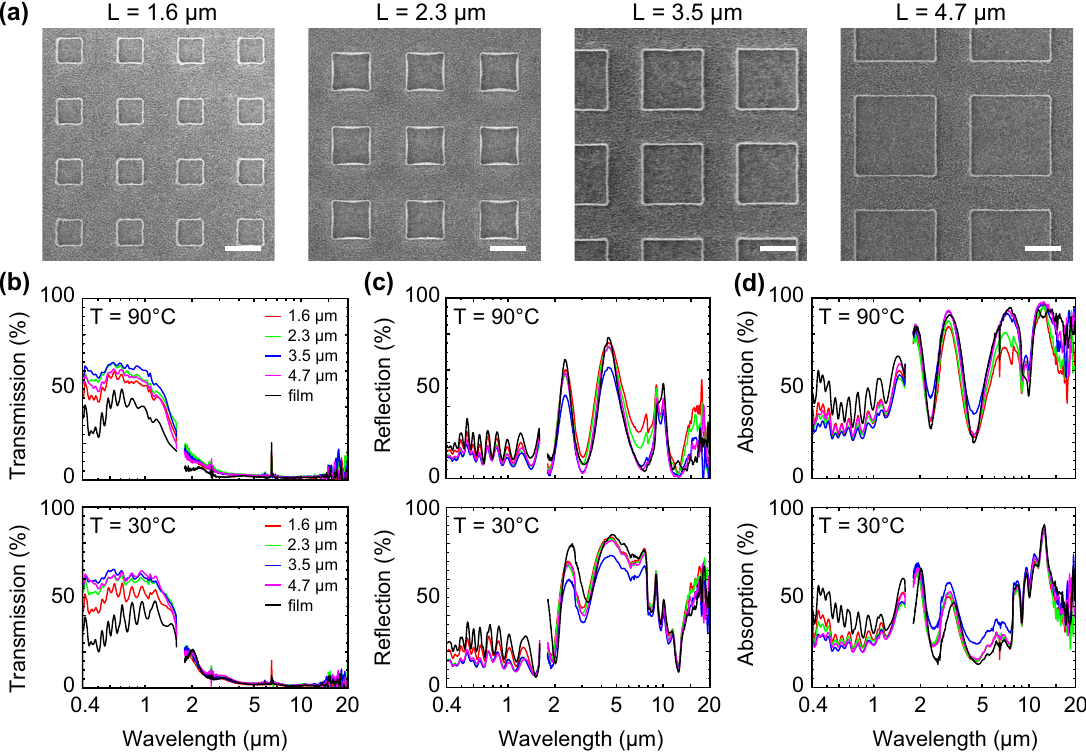
Figure 5: SEM images and experimental optical spectra of VO 2 metasurfaces as a function of feature size. (a) SEM images for metasurfaces with gap size fi xed at d = 2 µm and feature sizes L = 1.5 µm, 2.3 µm, 3.5 µm and 4.7 µm. (b – d) Transmission, re fl ection and absorption spectraat 30 ° C and 90 ° C, for the VO 2 metasurfaces with four differentfeature sizes (coloredlines) as wellas the unpatterned thin fi lmdevice (black